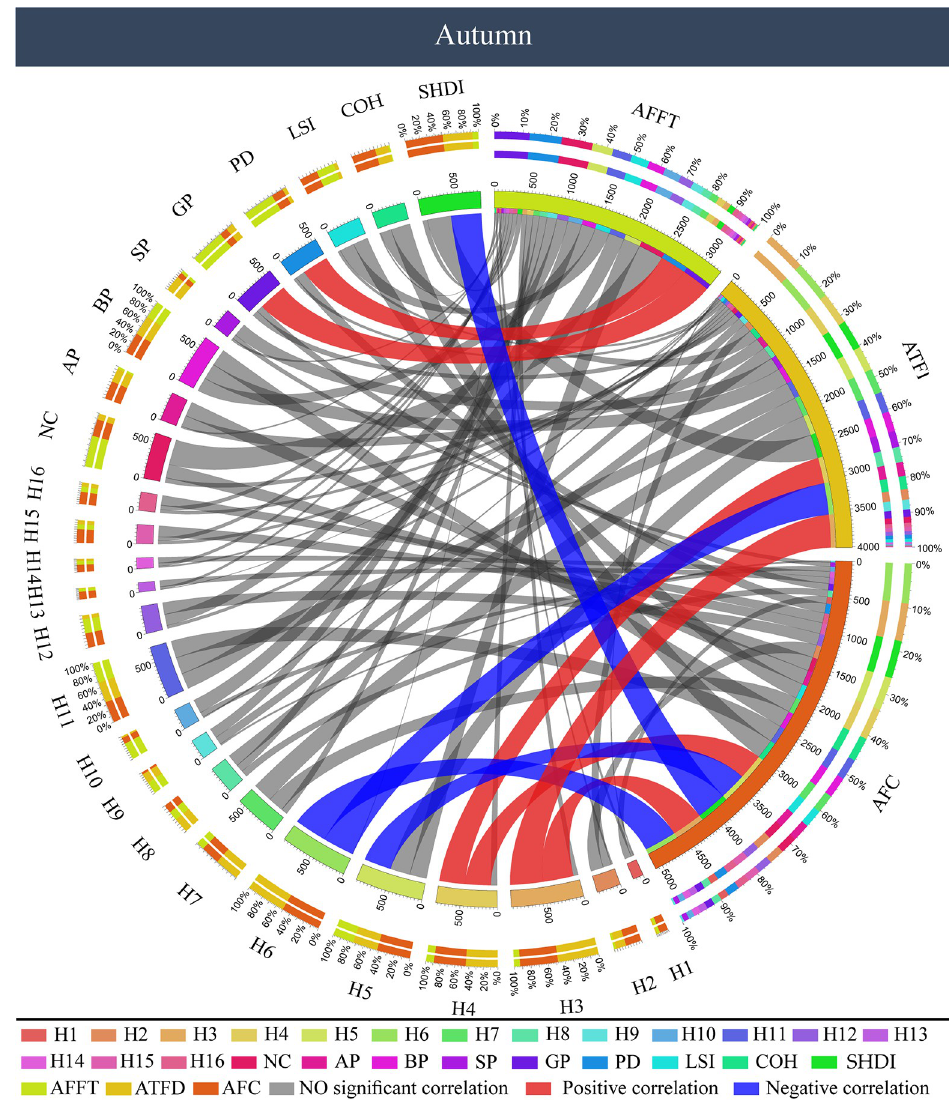
Fig 8. Correlation between color characteristics and visual behavior of forest color pictures in autumn. AFFT: AOI first fixation time, ATFD: AOI total fixation duration, AFC: AOI fixation count. correlated with yellow (H3, H4) and negatively correlated with green (H6) (P < 0.05). AOI fix- ation count (AFC) has a significant correlation with color components and color patch com- ponents. It is positively correlated with yellow (H3, H4), and negatively correlated with green (H5, H6) (P < 0.05). Among the color patch components, AOI fixation count (AFC) was only negatively correlated with the Shannon’s diversity index of color patch (SHDI) (P < 0.05). According to the correlation analysis results of color characteristics and visual behavior of winter forest color photos (Fig 9), among the color components, AOI first fixation time (AFFT) had a significantly positive correlation with red (H1, H2), and a significantly negative correlation with green (H5–9) and the number of colors (NC) (P < 0.05). For the visual behav- ior indicators AOI total fixation duration (ATFD) and AOI fixation count (AFC), a higher proportion of green (H6, H7) and a larger number of colors (NC) led to higher total fixation